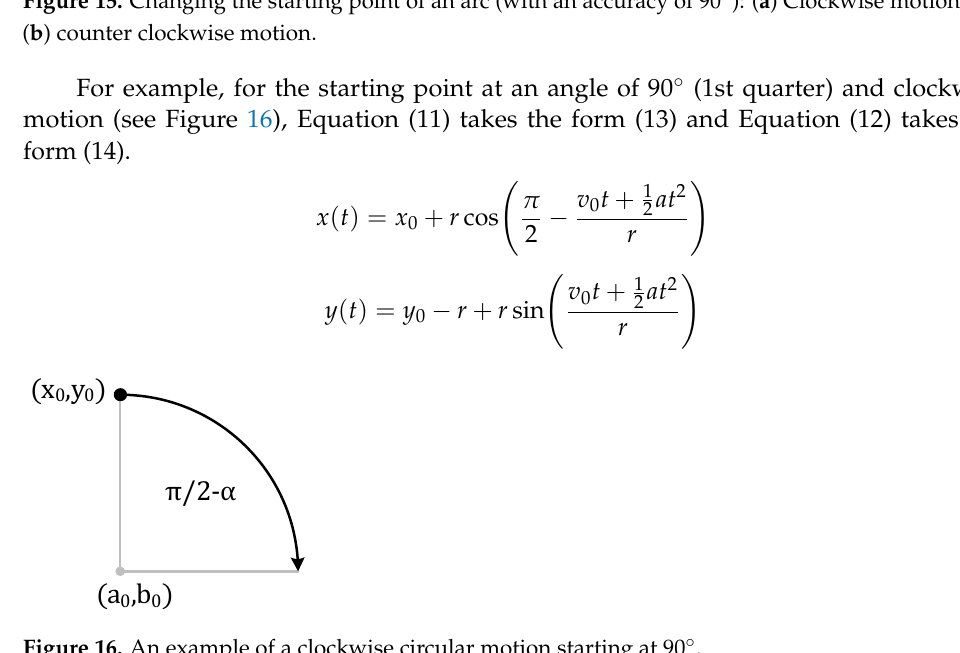
Figure 16. An example of a clockwise circular motion starting at 90 ◦ . Figure 17. The number of points defining the path depends on the time chosen for a single transmission between two UWB nodes (between tag and chosen